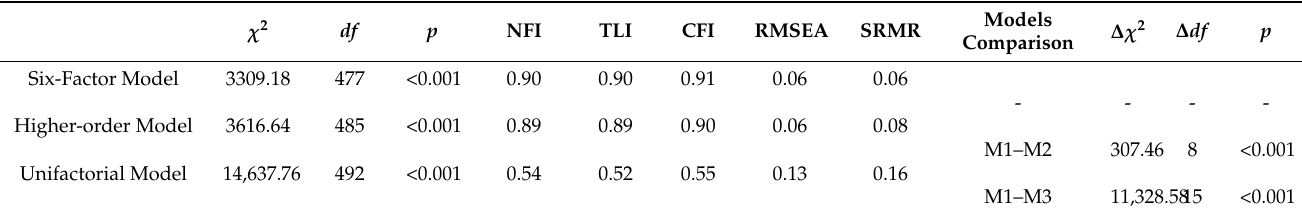
Table 2. Fit statistics of the MMQ for two factorial models and the chi-square variation